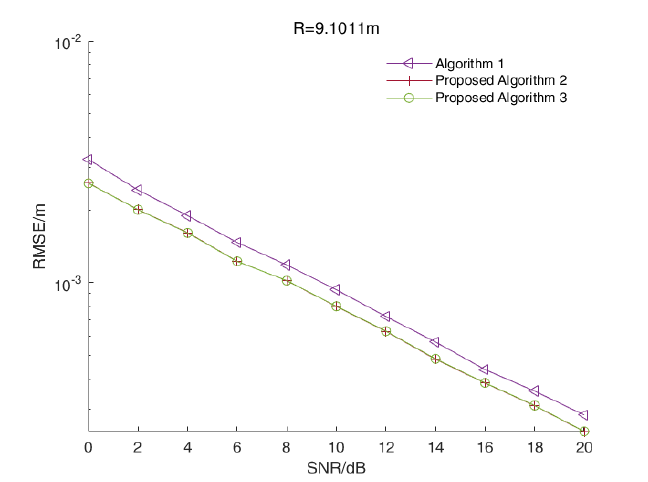
Figure 2. The RMSE values of the distance estimations versus the SNR values of all three algorithms in a single-target